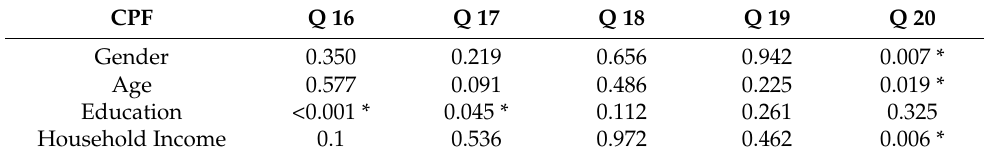
Figure 1. Consumer behavior activities for purchasing ( N = 400). Table 2. Consumers’ personal factors and consumer behavior